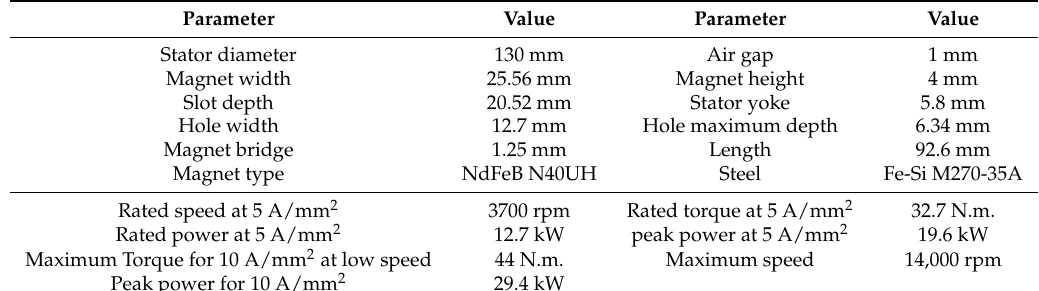
Table 1. Machine